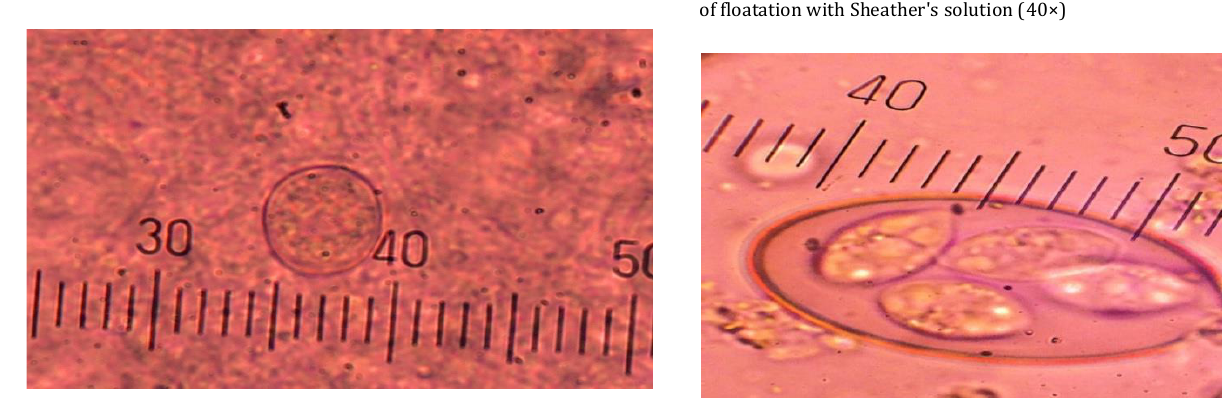
Eimeria parva No sporulated oocysts had spherical to sub-spherical shape with an average size of 15x13 μ m and smooth colorless surface; absence of polar cap and micropyl had also features of them (Figure 5).